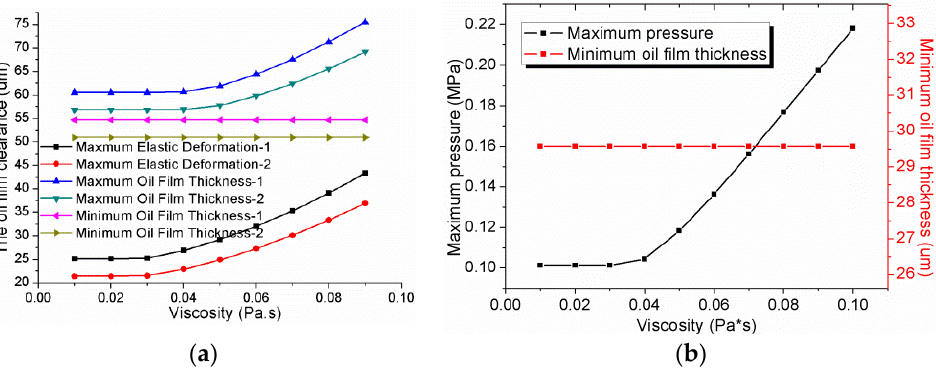
Figure 15. Effect of the viscosity on the oil film clearance and pressure. ( a ) The oil film thickness and the elastic deformation with the viscosity; ( b ) the minimum oil film thickness and maximum pressure with the viscosity.